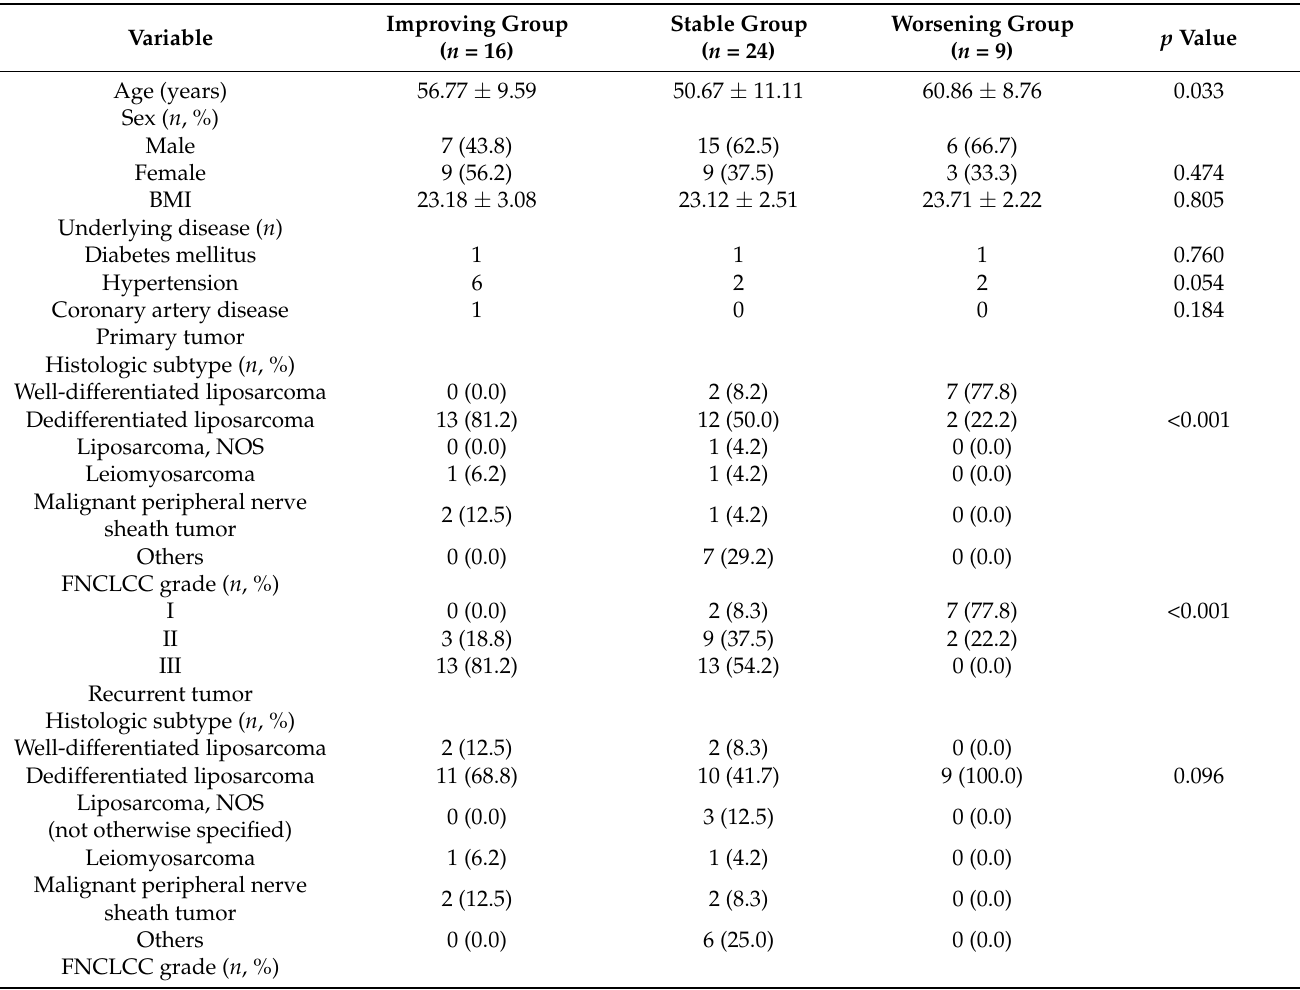
Table 2. Characteristics of patients.